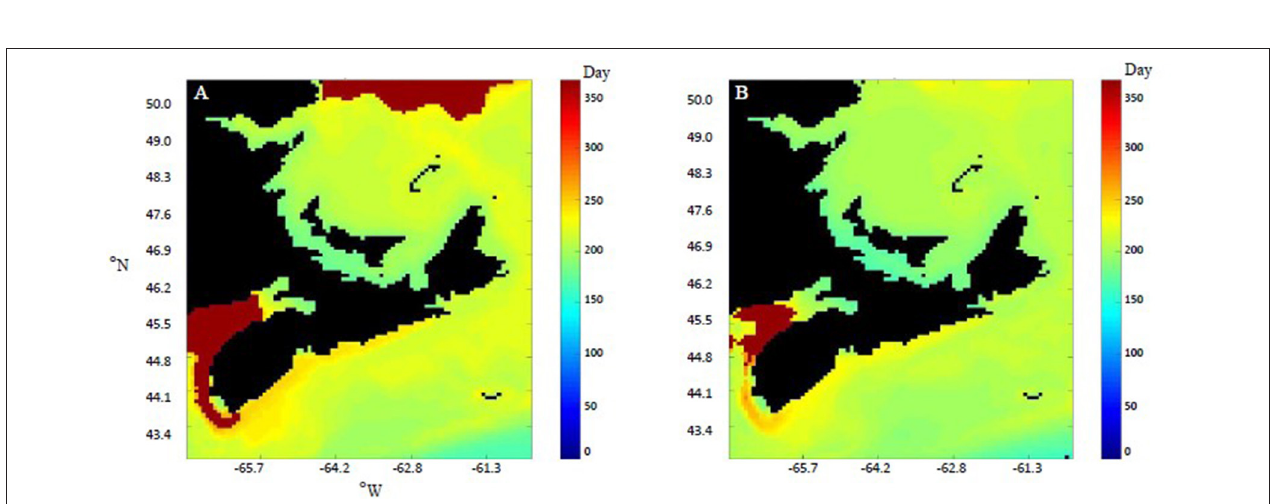
FIGURE 6 | The spawn date of M. edulis indicated in Julian day for the past (A) (1986–1990) and the future (B) (2046–2050). Spawn date was calculated as combination of temperature (14 ◦ C) (Newell and Moran, 1989) and GSI (0.28) (Troost et al., 2010) thresholds. Spawn dates above day 365 indicate that spawning did not occur in the first year of